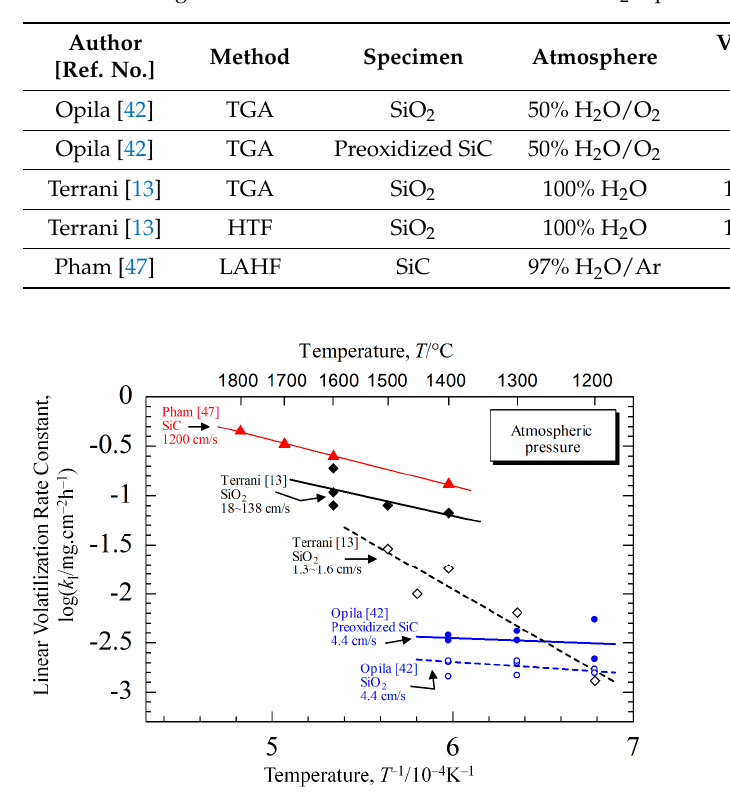
Figure 5. Summary of experimental results for linear volatilization rate of SiO 2 reported by